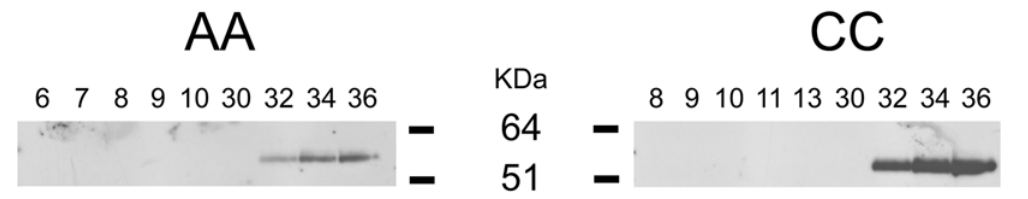
Figure 5. Analysis of membrane-associated IgG in AA and CC erythrocytes. Proteins from 9 fractions (out of a total of 36 fractions) were separated by SDS-PAGE under denaturing conditions, transferred to PVDF membrane, and probed with a monoclonal antibody specific for human